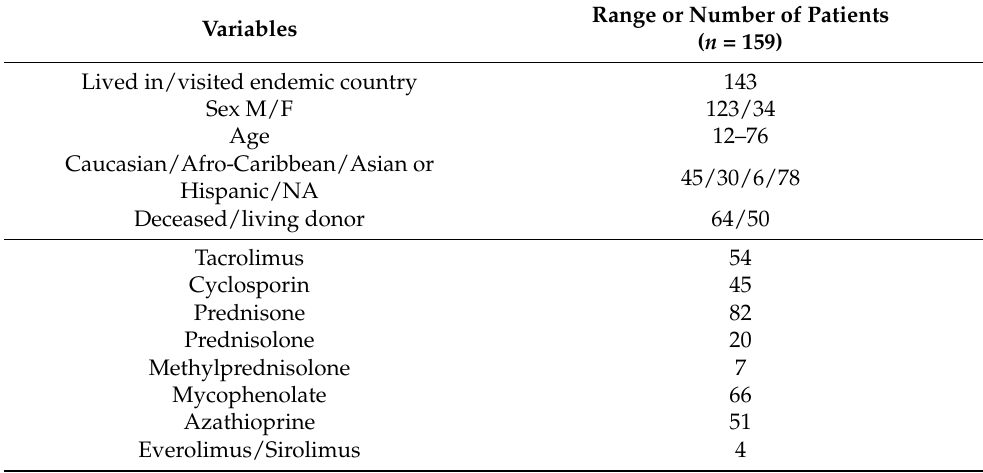
Table 2. Summary of the characteristics of the case reports and case series of Leishmania infection after kidney transplantation (summaries based on individual cases should not be considered as an estimate of the “real